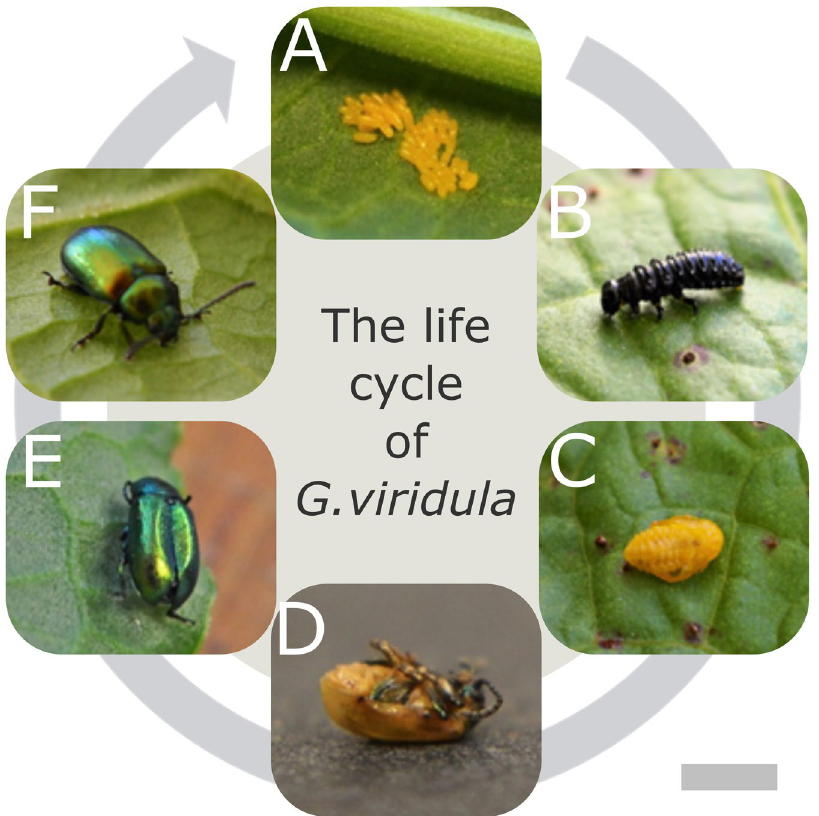
Figure 1. The life cycle of the G . viridula from the egg (( A ) day 0–7) to the adult ( F ) via the larval stages (( B ) days 8–18:), pupa (( C ) days 18–25), after ecdysis (( D ) day 25), and the final cuticle expansion (from ( E ) day 26). Scale bar: 1